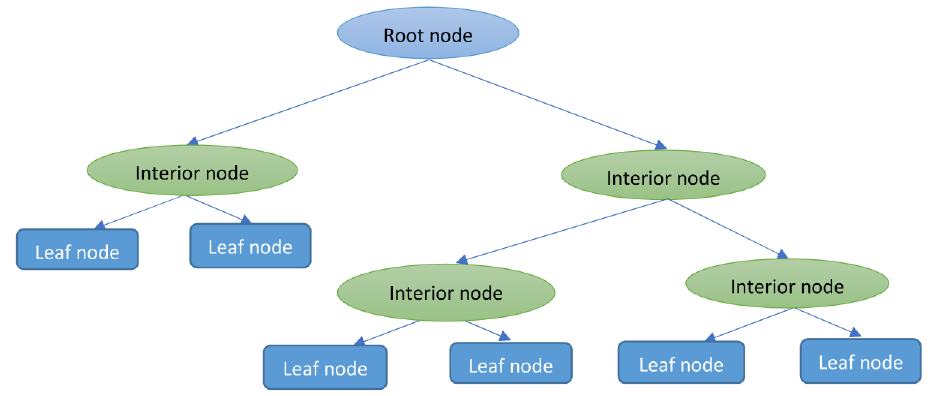
Figure 3. UAV Localization with Decision Tree Algorithm